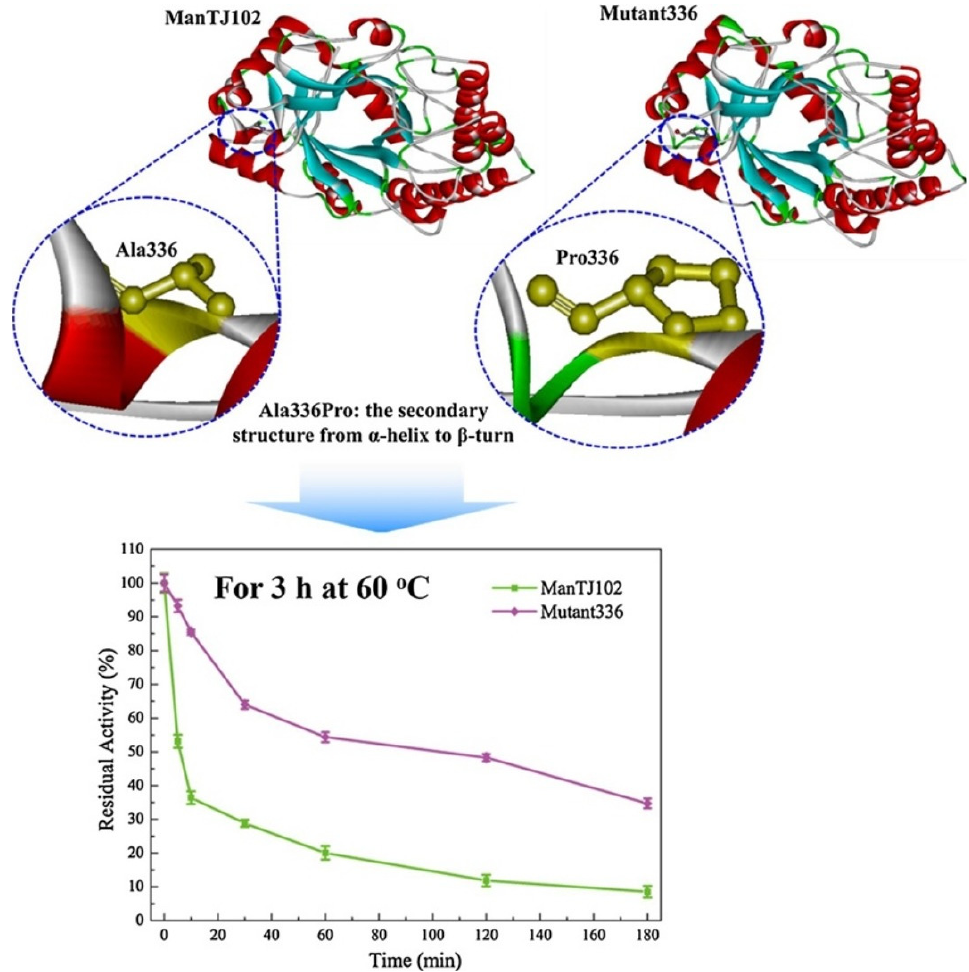
Figure 6. Thermostable β -mannanase enzyme mutant (mutant336 (A336 P) generated through rational design [60].